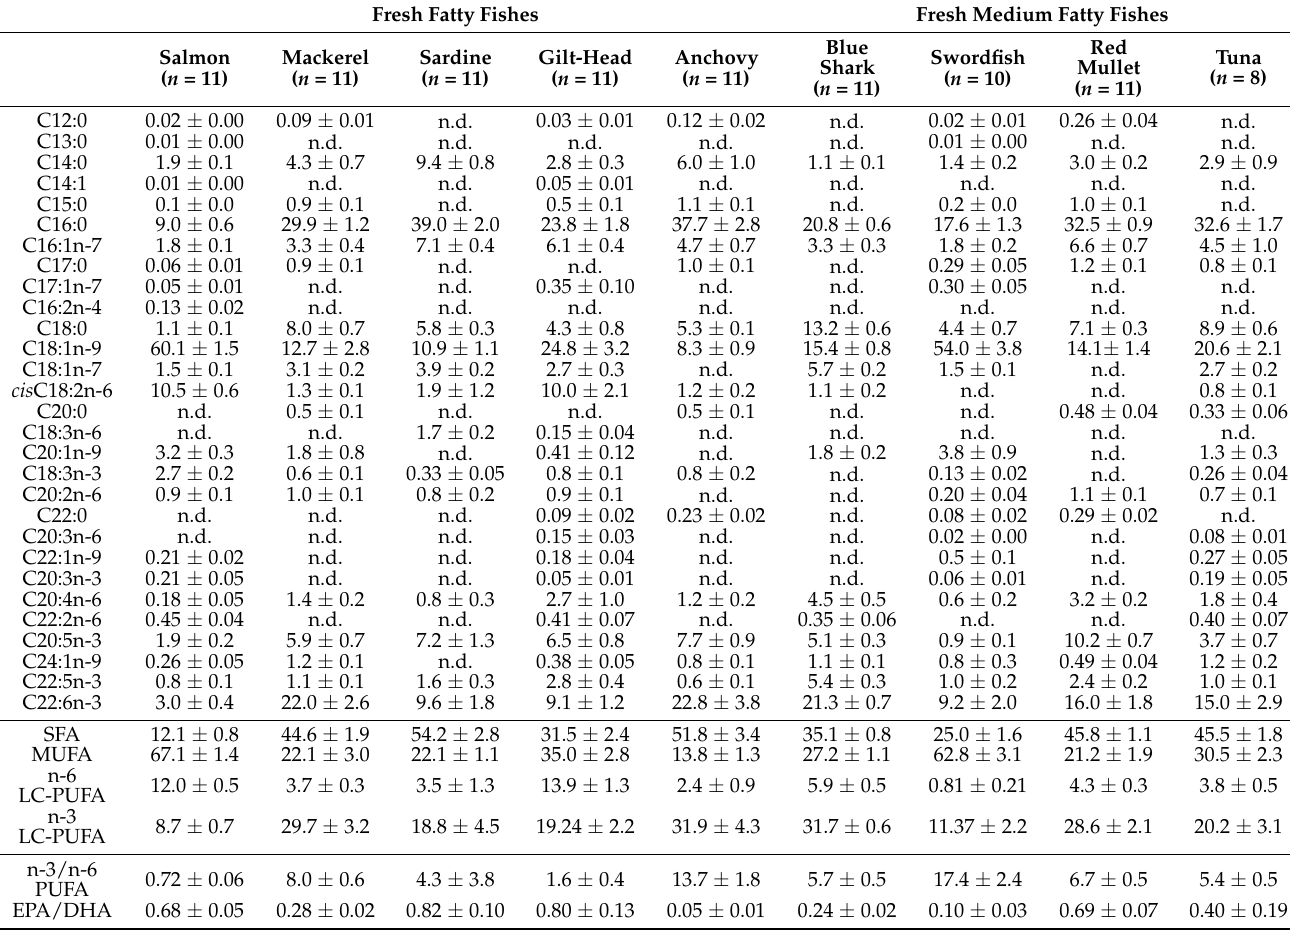
Data are presented as mean percentages ± SEM. Fishes were classified depending on their lipid content: (1) fatty (6–25% fat), (2) medium fatty (2.5–6% fat) and (3) lean fish (<2.5% fat) [1]. DHA, docosahexaenoic acid; EPA, eicosapentaenoic acid; MUFA, monounsaturated